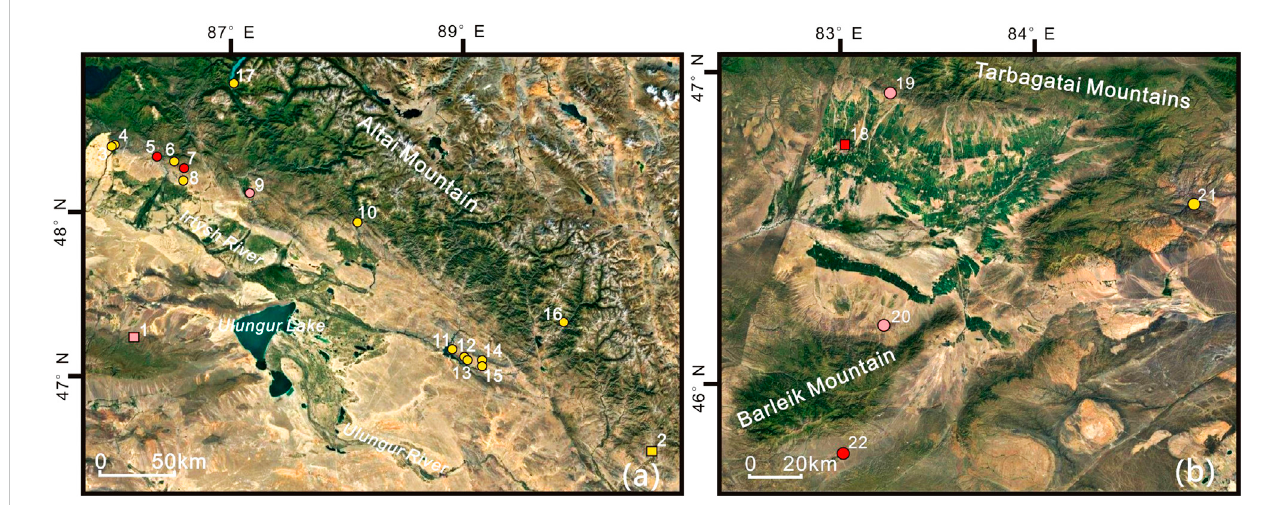
FIGURE 2 Topographic map of Junggar Basin and the sites mentioned in this study. (A) Northern margin area of Junggar Basin. 1. Tongtian Cave; 2. Huahaizi No.3; 3.Jialanggashi;4.Habahan;5.AyituohanNo.1;6.Dongtalede;7.TuoganbaiNo.2;8.Kalasu;9.ShankoushuidianinBurqinCounty;10.Wulasite;11.Taledesayi; 12. Qilikete; 13. Sawudiegeer;14. Sukeerte; 15.Saerbulake; 16. Zhelegabashi; 17. Tuwaxincun. (B) Westernmargin area of Junggar Basin 18. Xiakalangguer; 19. Abudulashuiku; 20. Aletengyemuleshuiku; 21. Baiyanghe; 22.